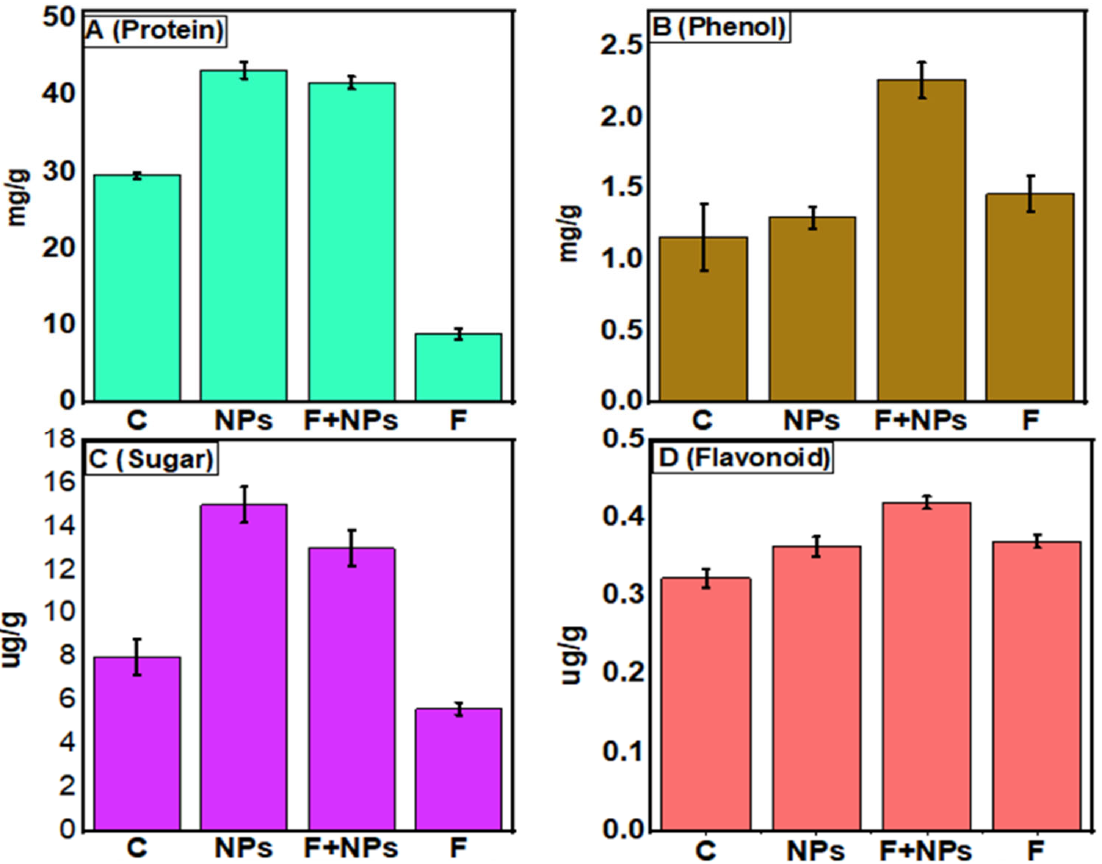
Figure 16. Estimation of different biochemical parameters including Protein ( A ), Phenol ( B ), Sugar ( C ), and Flavonoid ( D ) of chickpea under different growth conditions. C = control (without fungus), NPs = seeds primed with 0.5 μ g/mL ZnO NPs, NPs + F = seeds primed with 0.5 ug/mL ZnO NPs and sown in fungus inoculated soil, F = seeds sown in fungus inoculated soil.